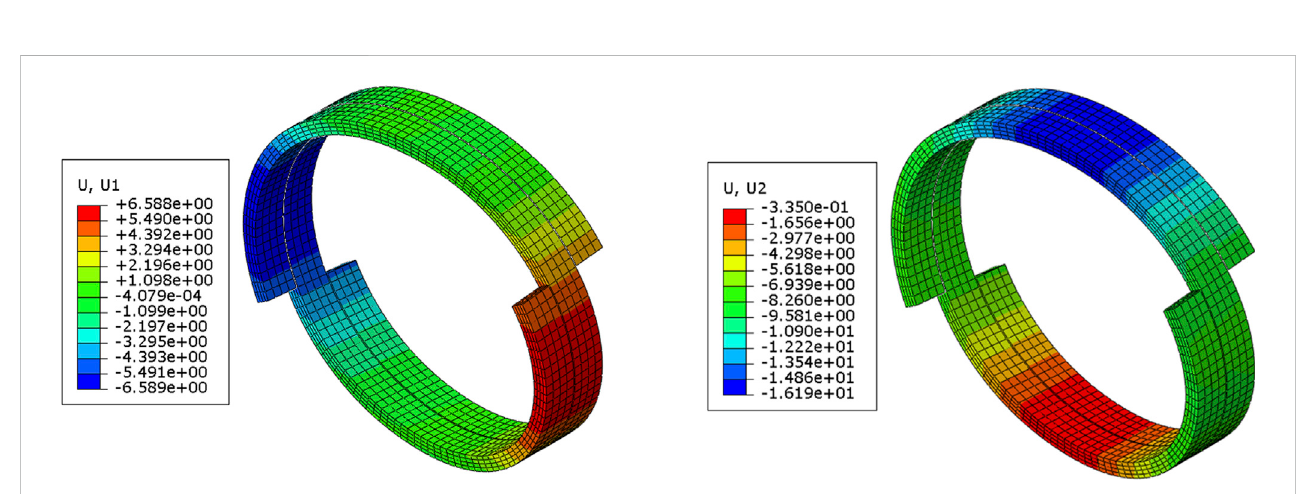
FIGURE 7 Displacement contour images of the hoop reinforcement layer. (A) Horizontal displacement, (B) Vertical